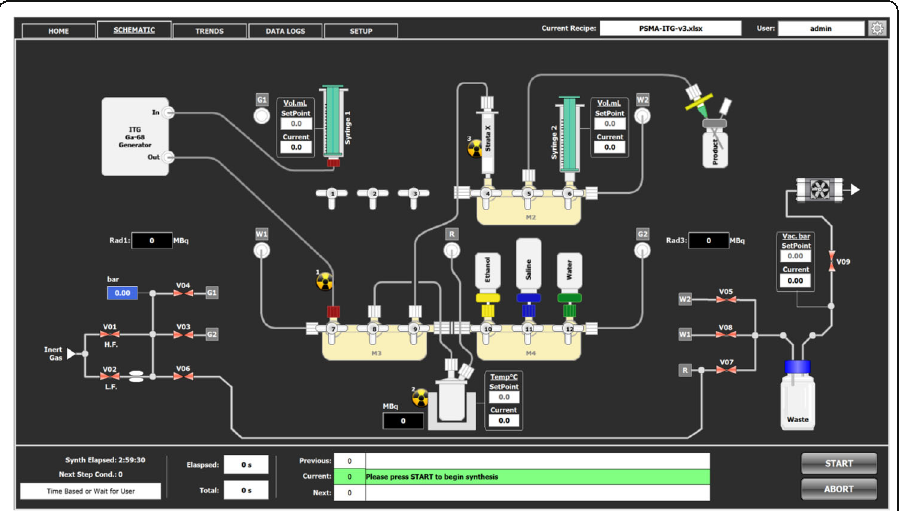
Fig. 1 Schematic of the MultiSyn module for production of Ga-68 labelled